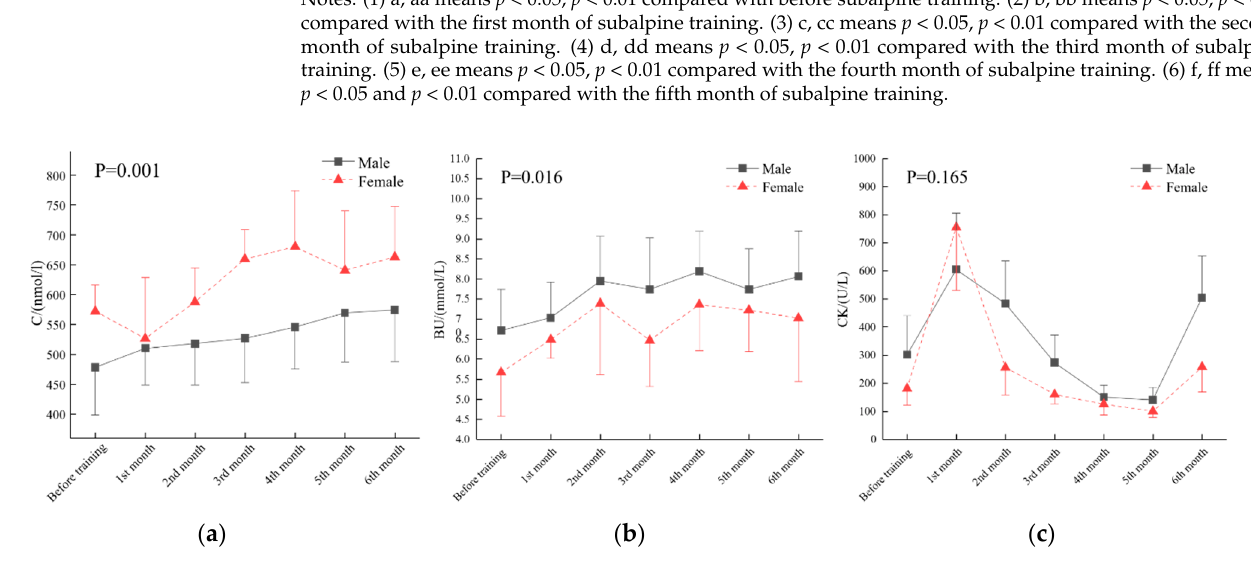
Figure 3. The results of changes in C, CK, and BU in the blood of athletes: ( a ) Changes of C in blood at different times; ( b ) Changes of BU in blood at different times; ( c ) Changes of CK in blood at different times. Data are mean ± SD.